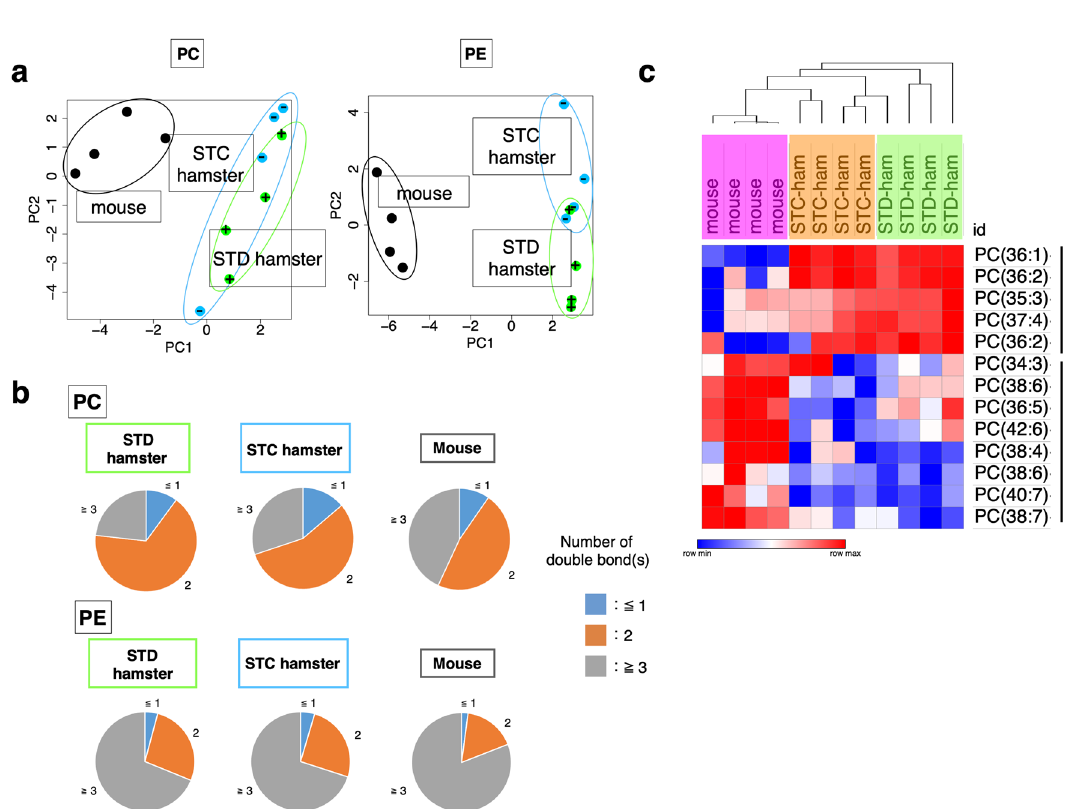
Fig. 3 Lipidome analysis revealed different phospholipid compositions of hepatocytes between mouse and hamster. a Principle component analysis (PCA) of PL-PC and PL-PE species in freshly isolated hepatocytes from mouse, STC hamster, and STD hamster. b Pie charts showing the average percentage of lipid species classi fi ed by the number of carbon – carbon double bonds. c Hierarchical clustering of the relative amount of PC species among distinct groups of animals. Relative abundance of each lipid species among samples is shown by blue red